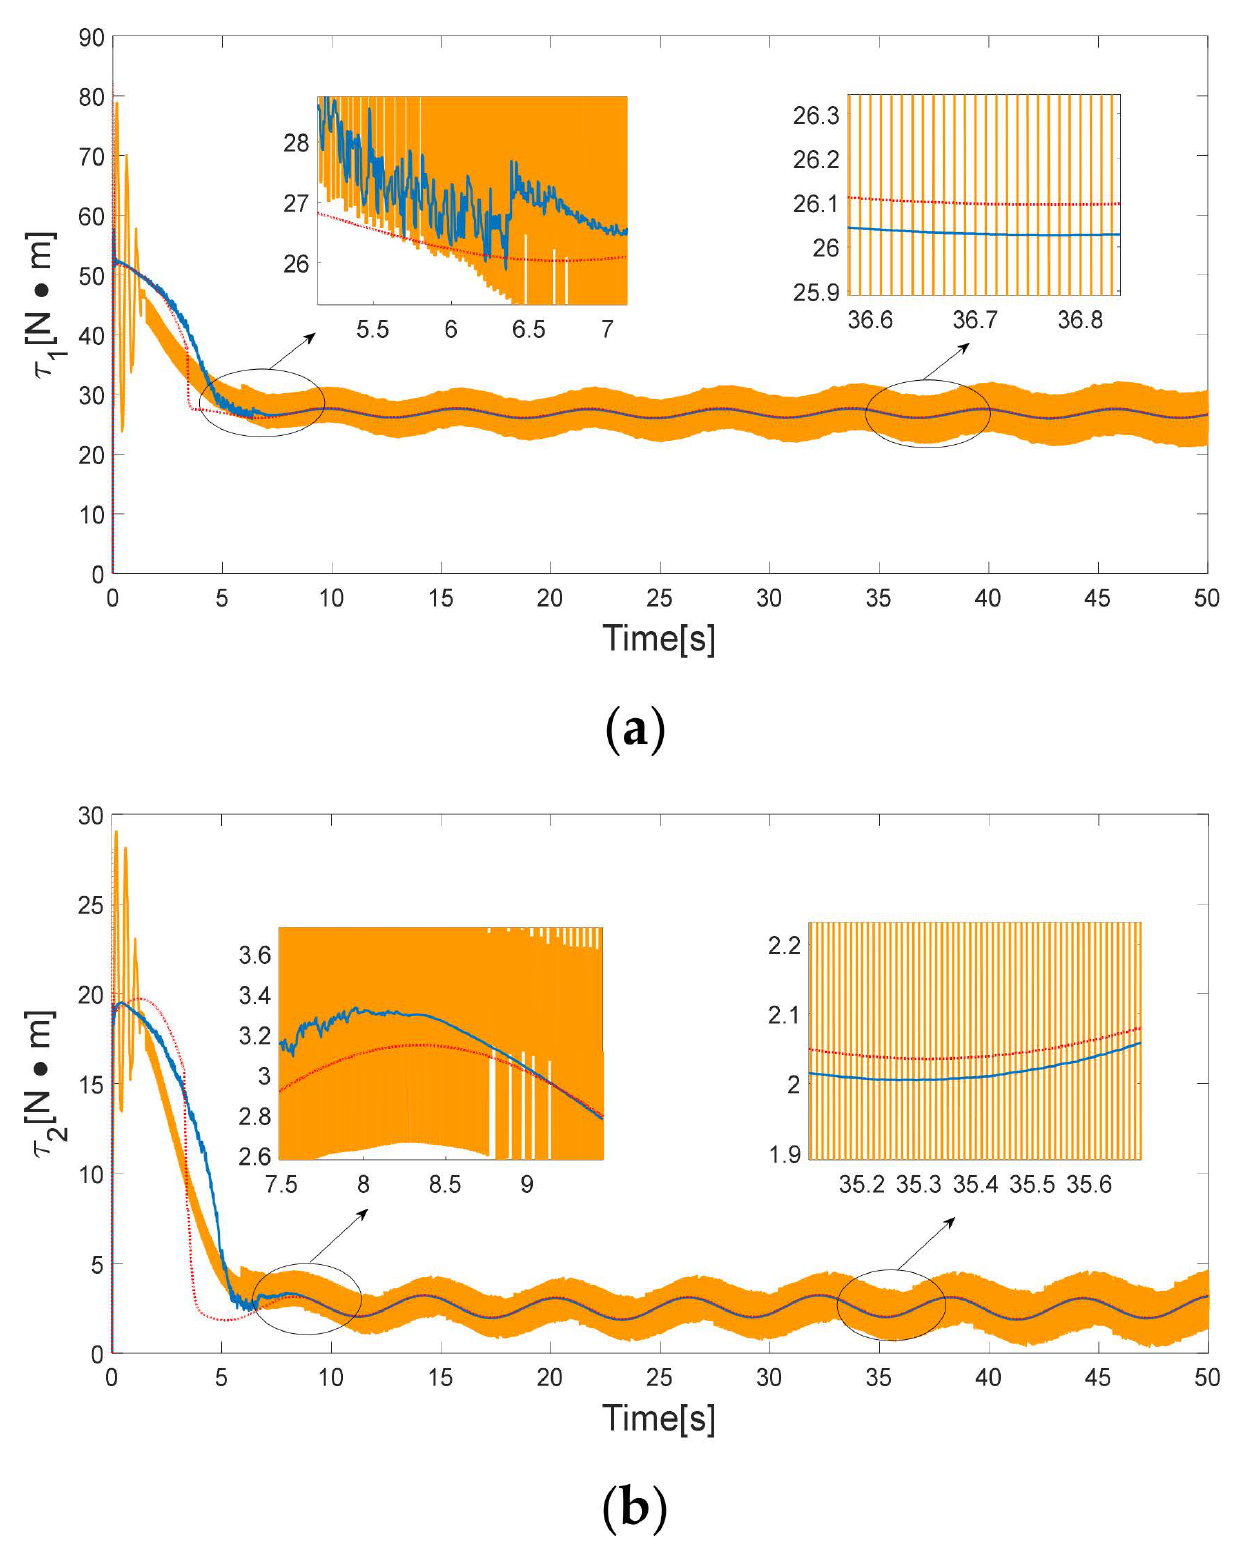
Figure 17. Comparison of torque to [43,44] in case 2: the [43] scheme (yellow solid line), the [44] scheme (red dash line), the proposed scheme (blue solid line); ( a ) Joint 1. ( b ) Joint